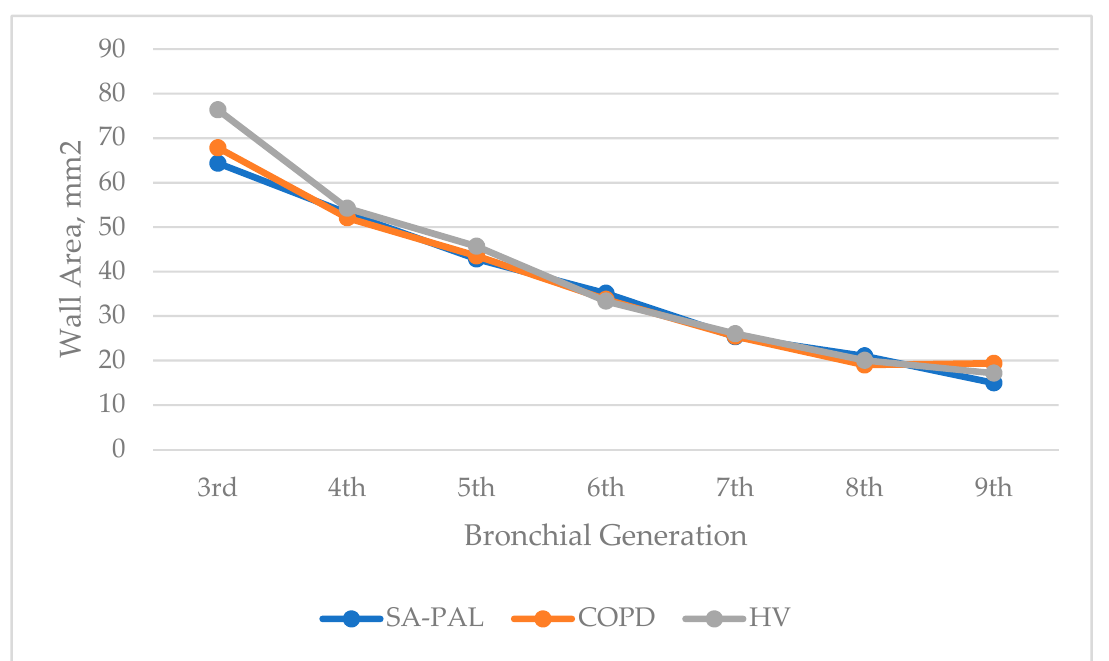
Figure 2. Wall area (WA) of the bronchial tree generations in patients in the SA-PAL, COPD, and HV groups.